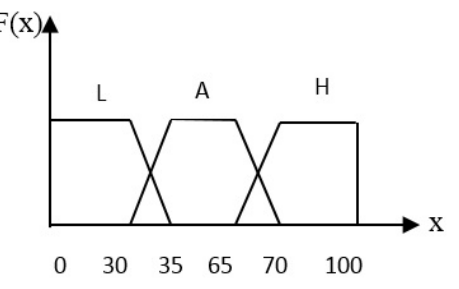
Figure 5. Three fuzzy sets in terms of ‘Low’, ‘Average’ and ‘High’ linguistic variables.